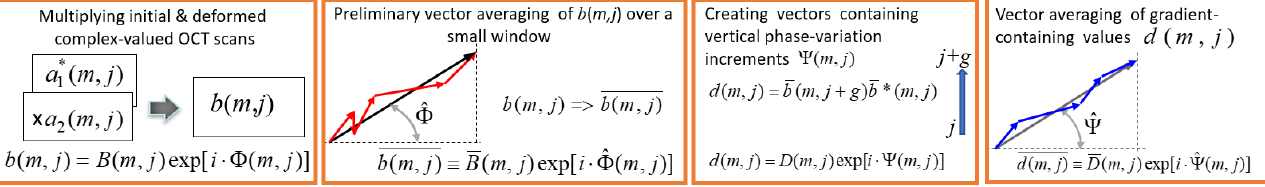
Figure 4. Schematic of the vector method for axial phase gradient evaluation. All intermediate calculations are performed with complex-valued signals considered as vectors in the complex plane. Phase gradient is extracted at the last processing step.